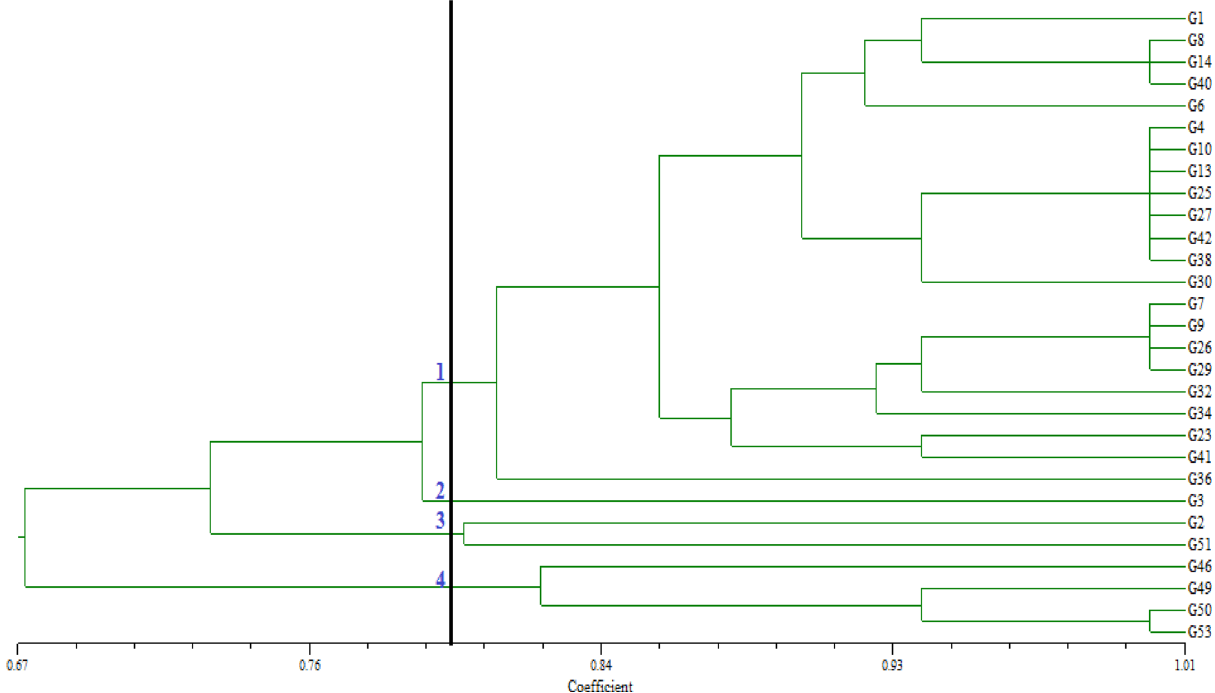
Figure 1. Dendrogram generated by UPGMA method using SSR marker.